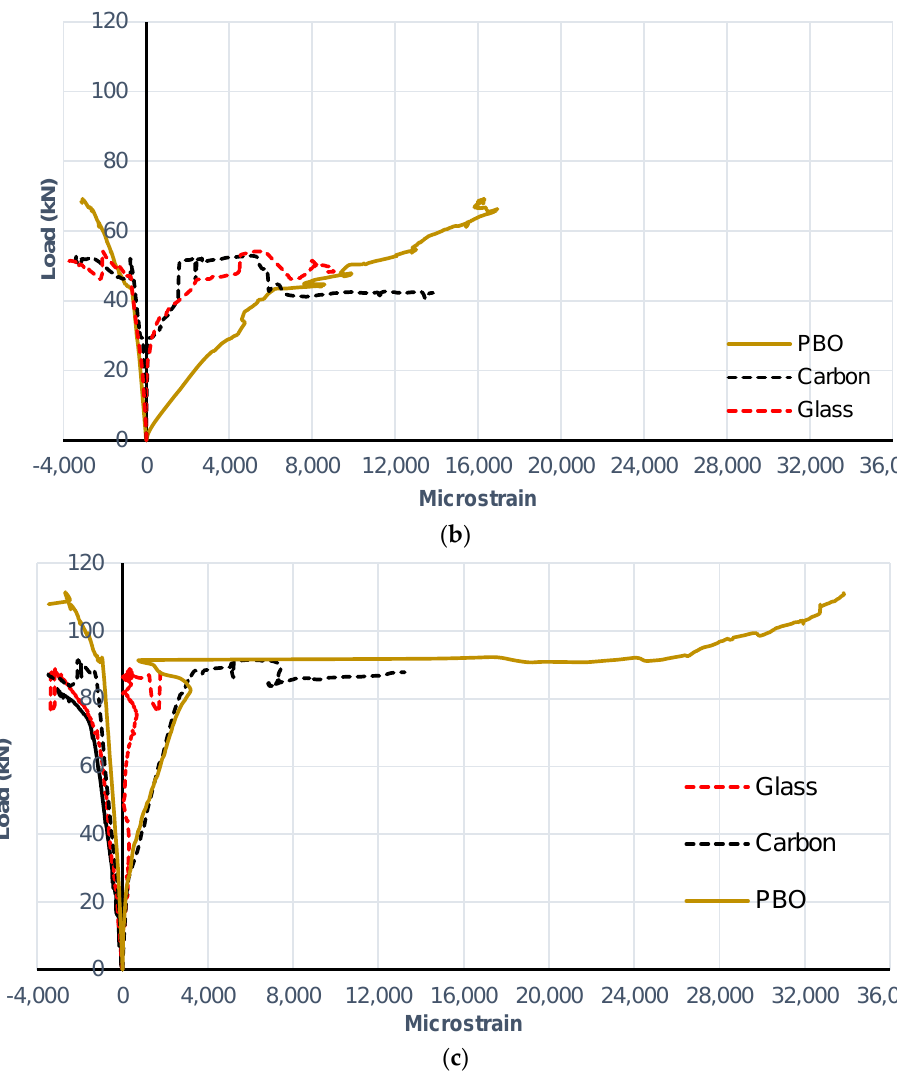
Figure 16. Load-FRCM strain behavior at mid-span: ( a ) B4-C: PI-gauge vs. strain gauge; ( b ) Group I; ( c ) Group II.